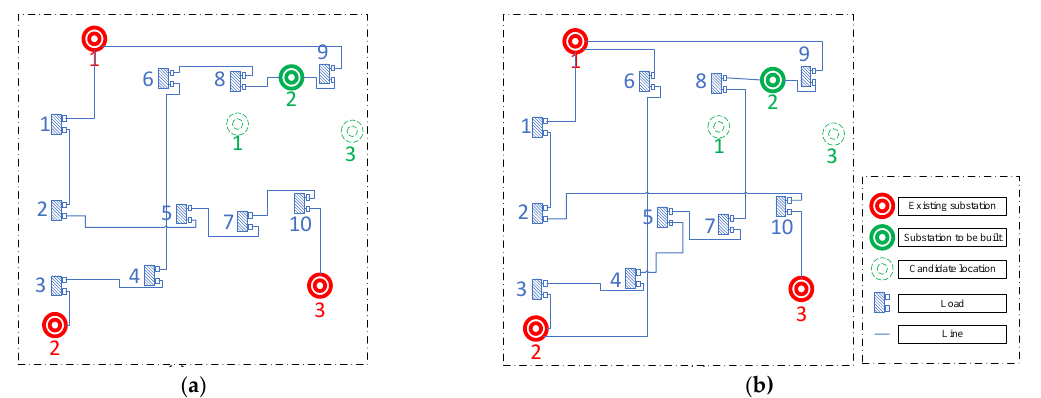
Figure 4. Planning schemes for the actual distribution system using different methods: ( a ) proposed BSA-based bi-level optimization method; ( b ) traditional single level optimization method [20].